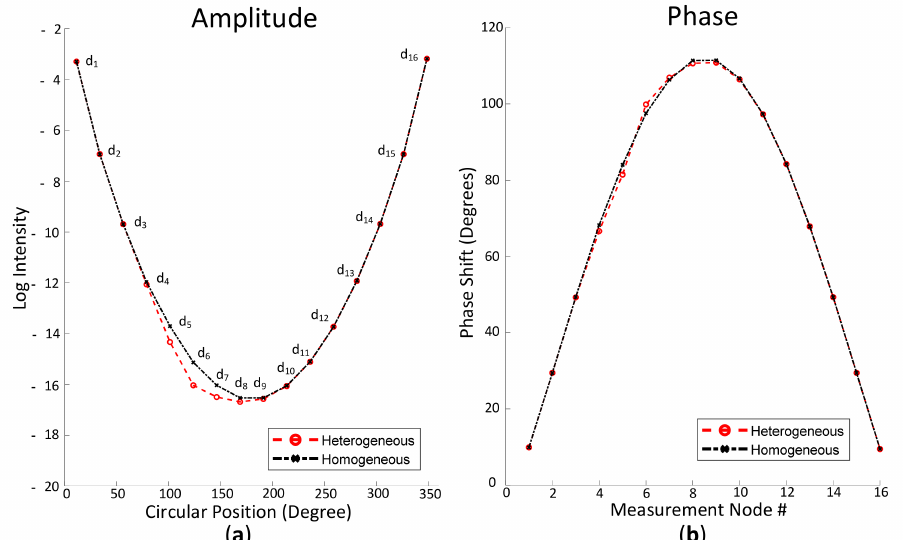
Figure 8. Obtained ( a ) light intensity and ( b ) phase shift from detectors attached around the model when S 1 was used as the source with a red, dashed line, indicating heterogeneity, and black, dashed line for homogeneity.